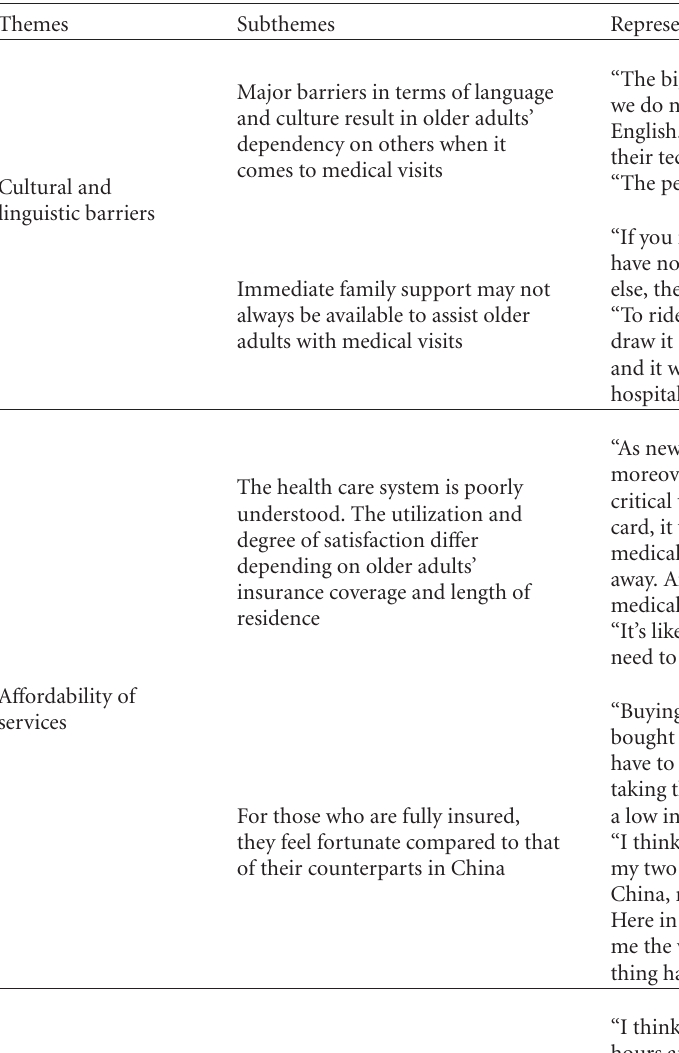
Table 2: Knowledge and Barriers to Health Care Services in the